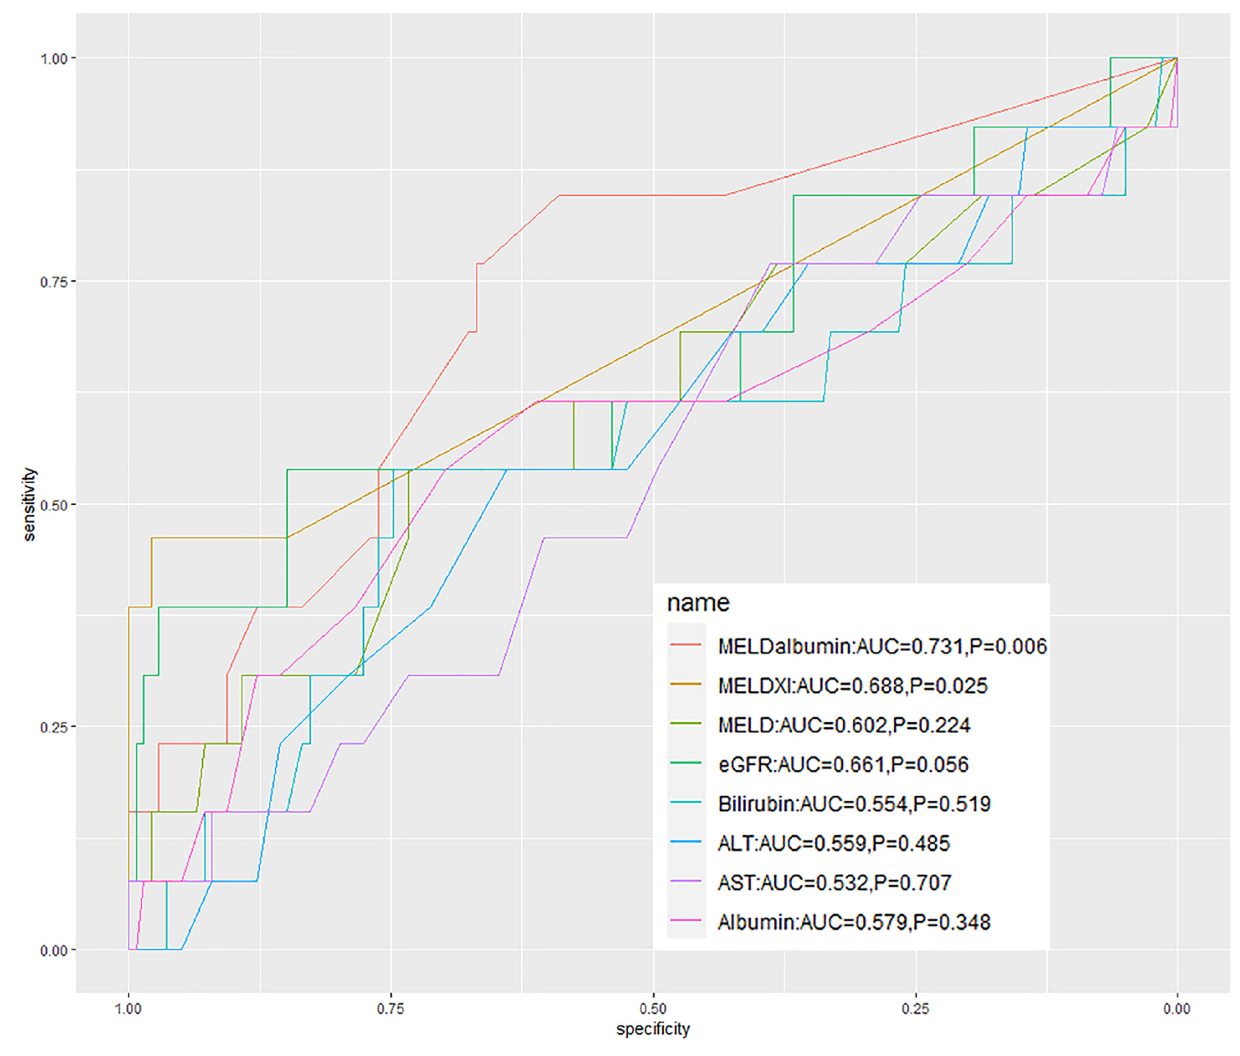
FIGURE 1 | The receiver operating characteristic curves of the hepatorenal biomarkers to determine the accuracy to predict the in-hospital mortality following ITVR. MELD, a model for end-stage liver disease; MELD-albumin, model for end-stage liver disease with albumin replacing international normalized ratio; MELD-XI, model for end-stage liver disease excluding international normalized ratio; eGFR, estimated glomerular filtration rate; ALT, alanine transaminase; AST, aspartate transaminase; AUC, area under the